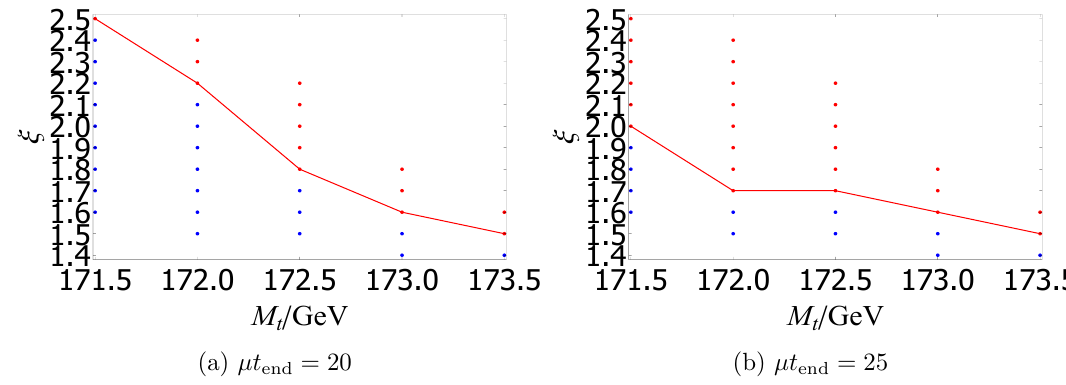
Figure 5. Vacuum stability bounds on ξ for different values of the top quark mass M t , taking α s = 0 . 1179 and µt end = 20 and 25 . The red (blue) dots show the sample points with (without) the instability of the electroweak vacuum. The red line indicates our upper bounds on ξ .